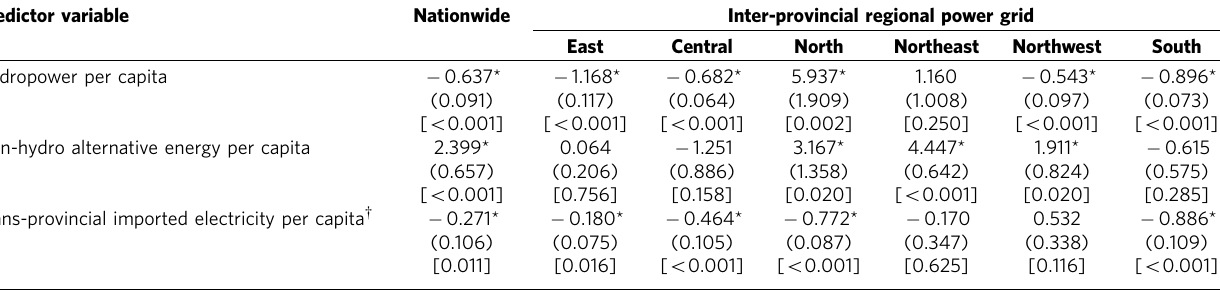
Table 3 | Displacement coefficients of hydropower and non-hydro alternative energy sources nationwide and in the six inter-provincial regional power grids.